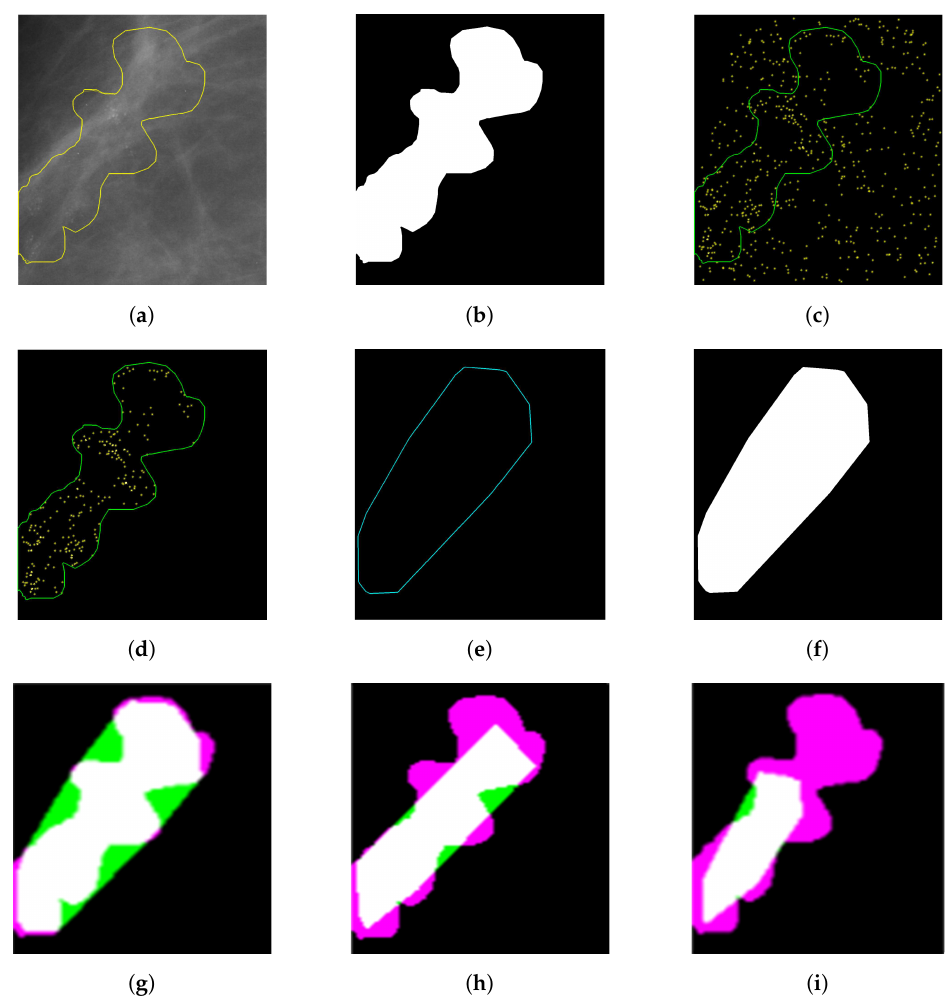
Figure 8. ( a ) Annotation by radiologist ( B _3121_1. RIGHT _ MLO ); ( b ) reference MC cluster mask generated from ( a ); ( c ) border extraction from reference MC mask and overlaid on segmented image generated using morphological segmentation approach; ( d ) MC resides inside the border annotated by expert radiologist; ( e ) convex hull outline using the border points of segmented blobs residing inside annotation outline; ( f ) mask generation from convex hull border of segmented image; ( g ) Dice similarity score (based on morphological segmentation approach) = 0.85599 (white region, true positive; green region, false positive; magenta region, false negative); ( h ) Dice similarity score (based on Oliver’s [38] segmentation approach) = 0.76514; and ( i ) Dice similarity score (based on area ranking segmentation approach) =